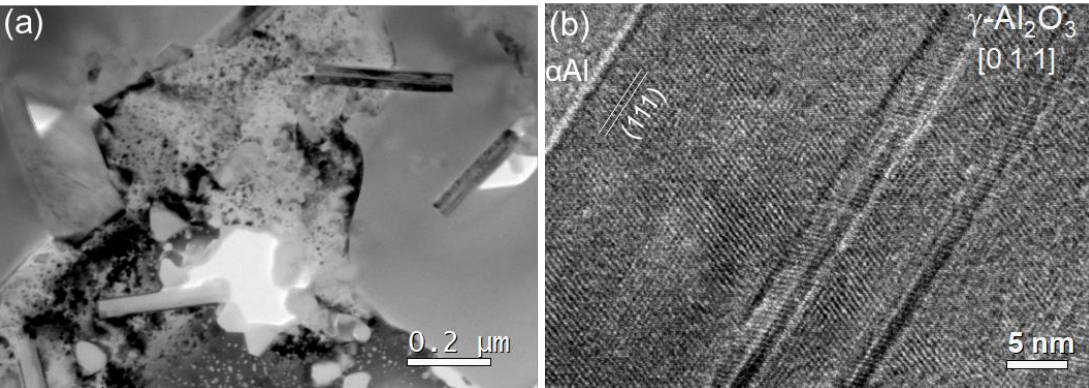
Figure 33. Faceted behavior of the native γ -Al 2 O 3 particles in CP-Al melt [75,86]. TEM micrograph showing ( a ) the typical morphology of the faceted γ -Al 2 O 3 particles in commercial purity Al (CP-Al) melt, which display a platelet-like morphology about 50 nm thick and 200 – 300 nm long on an average; and ( b ) high resolution TEM micrograph showing the γ -Al 2 O 3 particle is faceted and twinned along its {1 1 1} planes.